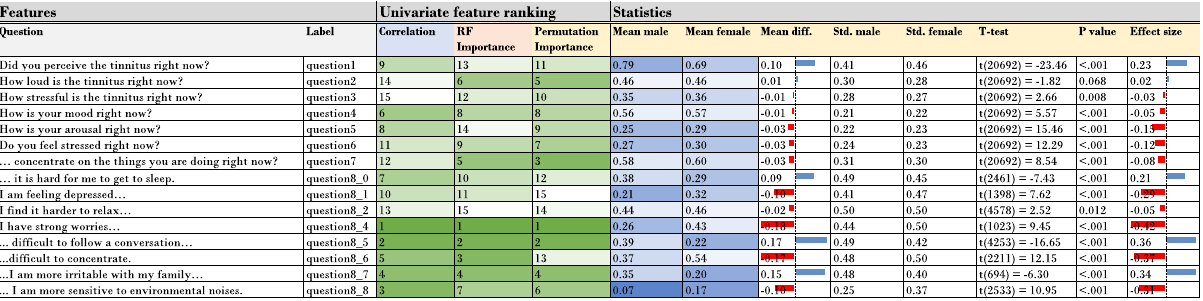
Figure 2. Comparison of three approaches to determine the most important feature for gender prediction. A ranking value of 1 means that this feature is most important to predict the gender.